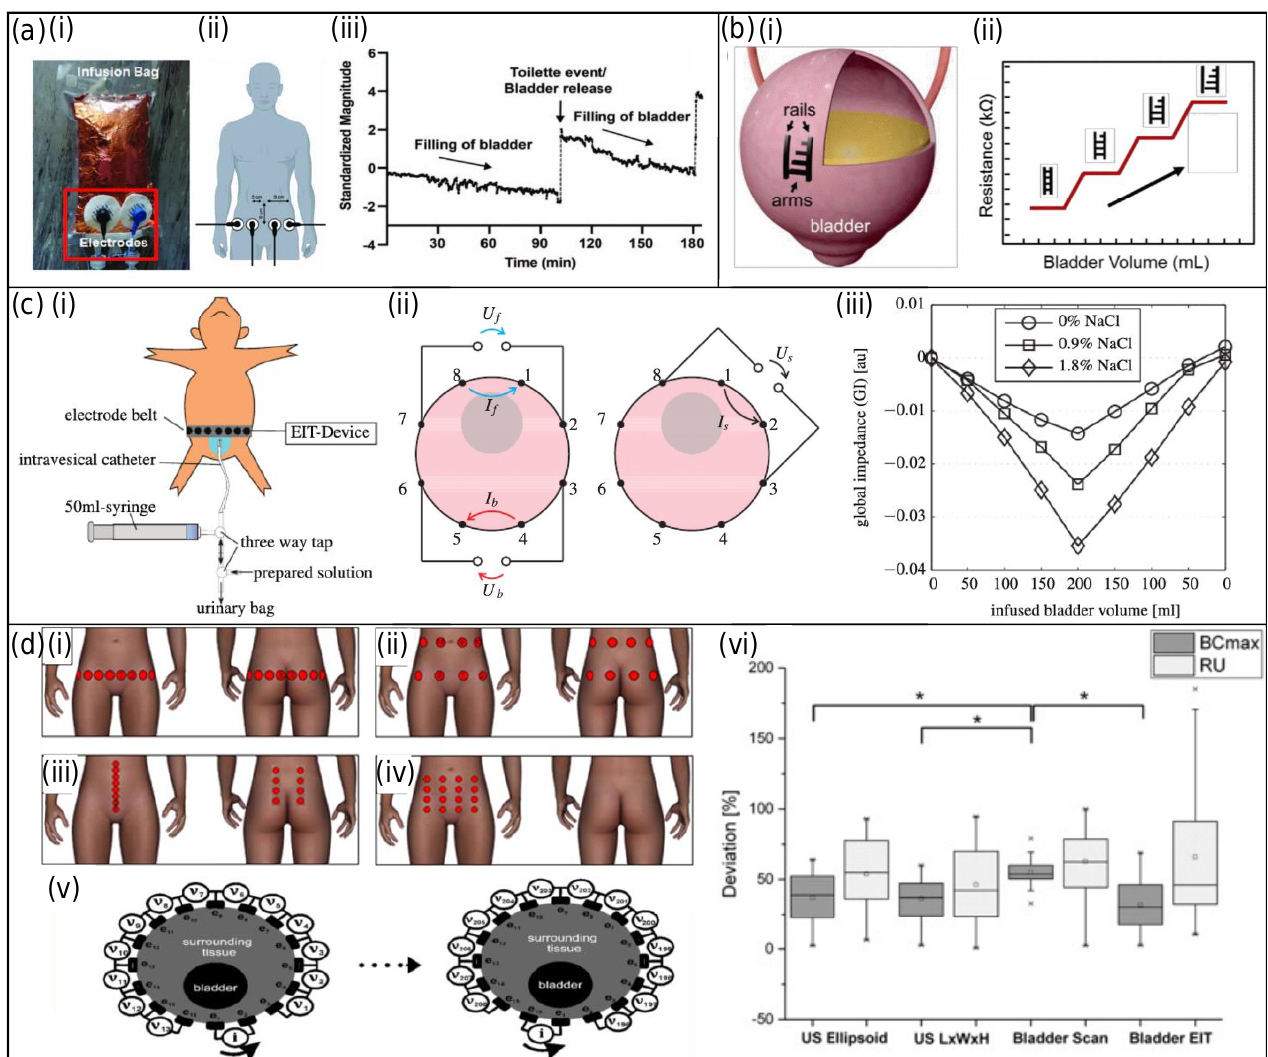
Figure 6. Bladder-monitoring devices. ( a , i ) The bioimpedance sensor on an infusion bag, ( ii ) a schematic of the position of electrode position on the body, and ( iii ) impedance versus time characteristics [59]. Copyright 2020, IEEE. ( b , i ) The multi-level resistor bioimpedance sensor, and ( ii ) the discrete changes in the resistance of the sensor due to the number of attached arms [61]. Copyright 2017, IEEE. ( c , i ) The experimental setup of in vivo measurements showing the electrode belt with attached EIT device, ( ii ) the impedance ratio method using three tetrapolar measurements, and ( iii ) the influence of urine conductivity on EIT global impedance [91]. ( d , i – iv ) Four different electrode configurations for EIT measurements — each configuration has 16 electrodes, ( v ) global impedance method displaying the 16 electrode ring arrangement, and ( vi ) the deviation of different measurement tools for cystovolumetry compared to the actual bladder volume [92].